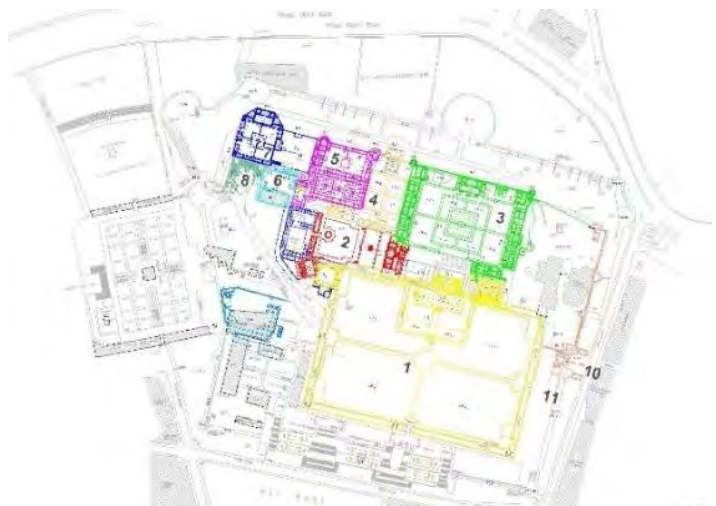
Figure 3. Quadrangles of Lahore Fort